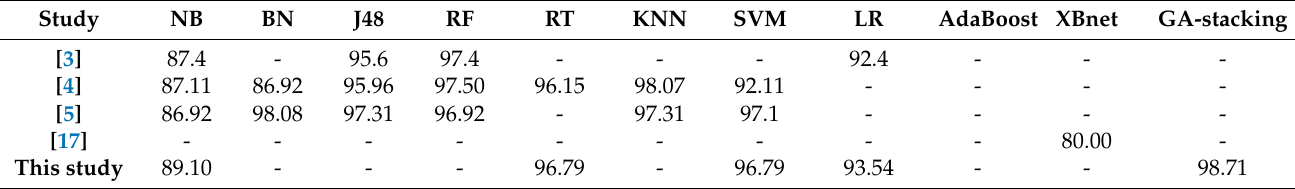
Table 3. Studies results